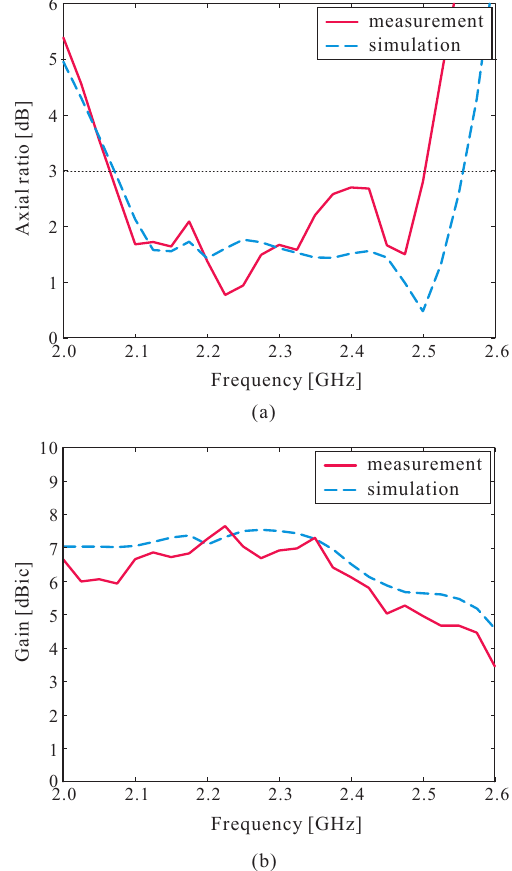
Figure 9. Measured and simulated results of: ( a ) Axial ratios; ( b ) Left-handed circular polarization (LHCP)